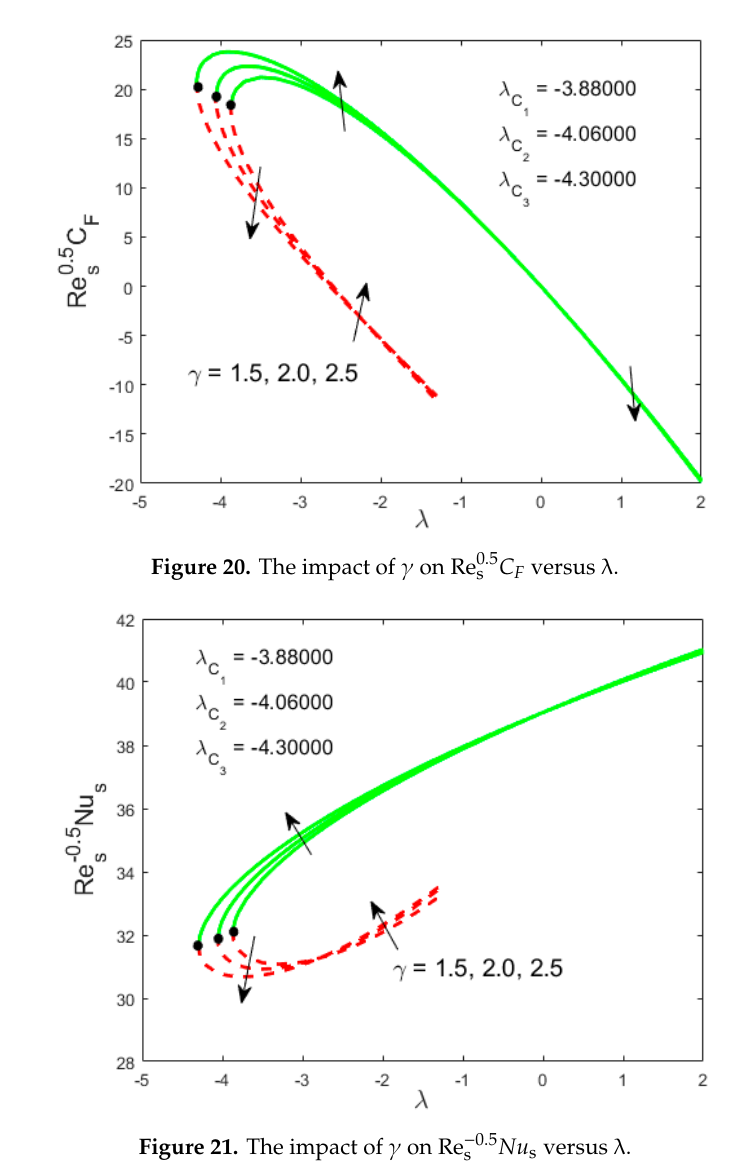
Figure 21. The impact of